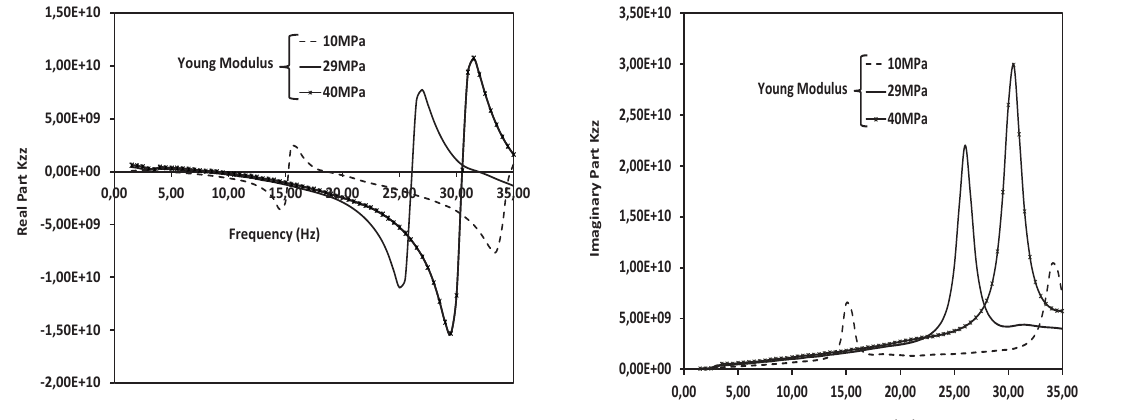
Figure 14 Vertical and horizontal response for the maximum │U/F│̶ Figure 14: Vertical and horizontal response for the maximum │ U/F │ ̶ Influence of the cylinder depth Influence of the cylinder depth. Vertical and horizontal dynamic response of suction caisson foundations